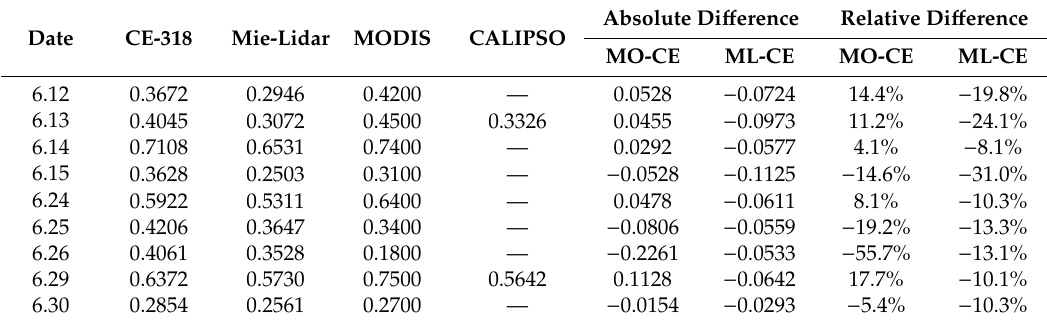
Table 2. Comparison of AOD (aerosol optical depth) estimated using ground-based and airborne data